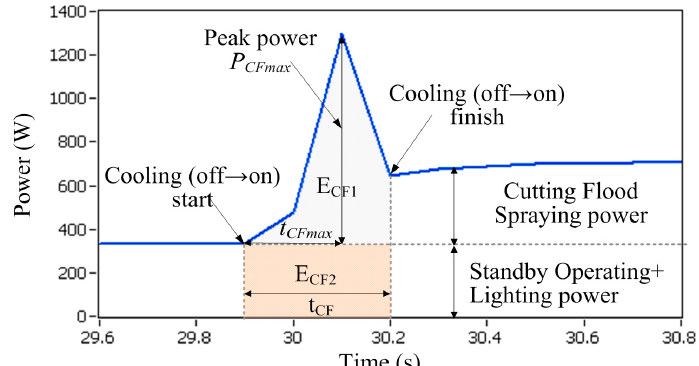
Figure 8. Power curve of cooling (off → on).